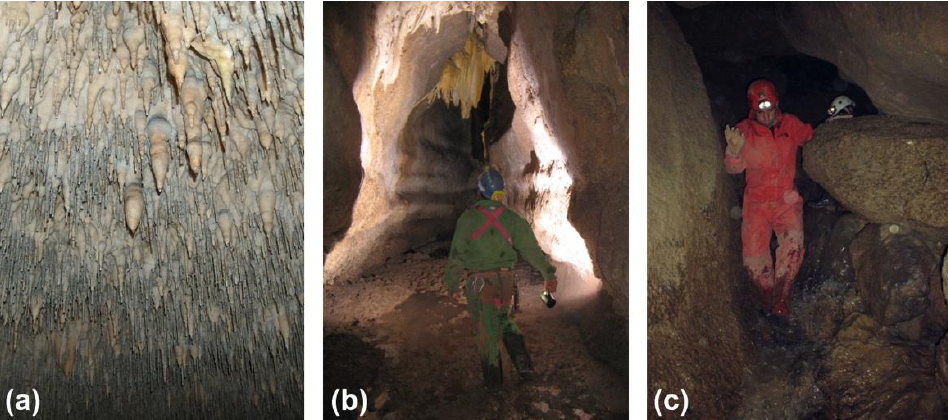
Figure 14. ( a ) Roof of the Carburangeli cave densely covered by stalactites; ( b ) The upper gallery of Santa Ninfa cave, showing calcite speleothems; ( c ) The active gallery of Sant’Angelo cave, flown by the underground stream.